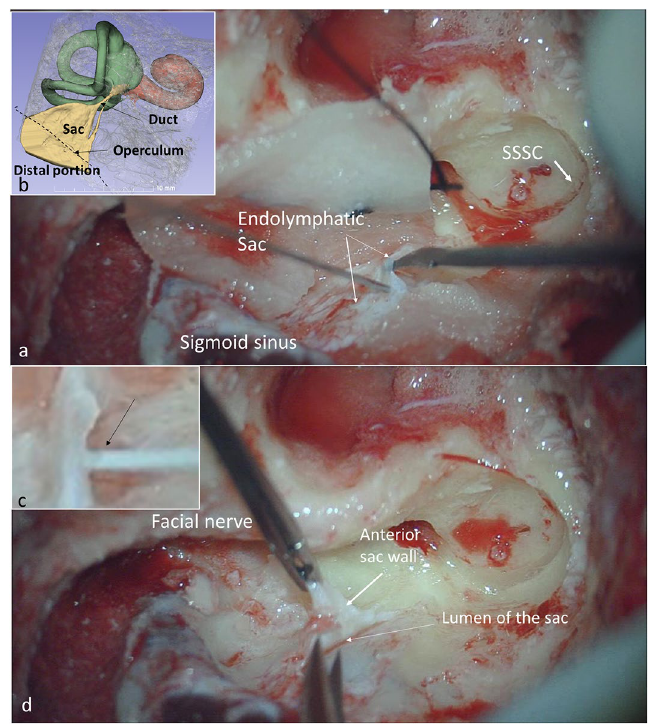
Figure 1. Surgery and biopsy for proteome analysis of the endolymphatic sac. ( a ) During surgical labyrinthectomy the endolymphatic sac is reached from the lateral side. The sac is opened from the duct region in order not to contaminate its content. The sac reaches to the sigmoid sinus. ( b ) Micro-CT of human temporal bone shows the three principal parts of the labyrinth presented in different colours (scale 10 mm). The operculum is the bony ledge separating the intraosseous from the extraosseous part. SSCC ; superior semicircular canal. ( c ) Collection of ES luminal fluid (arrow) by using the in-situ sampling SPME probe. ( d ) Biopsy of the endolymphatic sac wall is